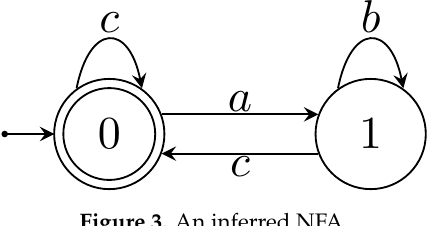
Figure 3. An inferred